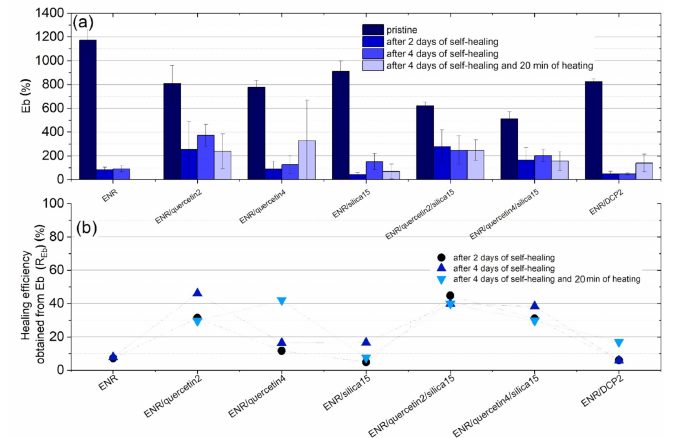
Figure 5. Elongation at break (Eb) of tested materials before and after self-healing process ( a ) and healing efficiency calculated using Eb results for every material after 2 days, 4 days and 4 days with 20 min of heating ( b ).